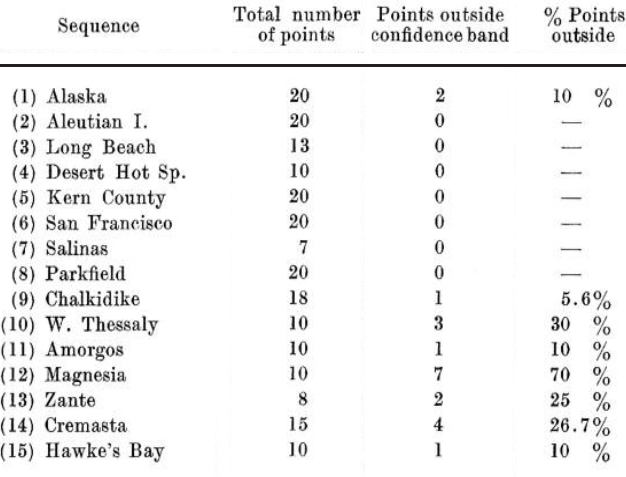
Table 4. Fluctuations of the observed frequencies in the decay of after- shock activity with time.